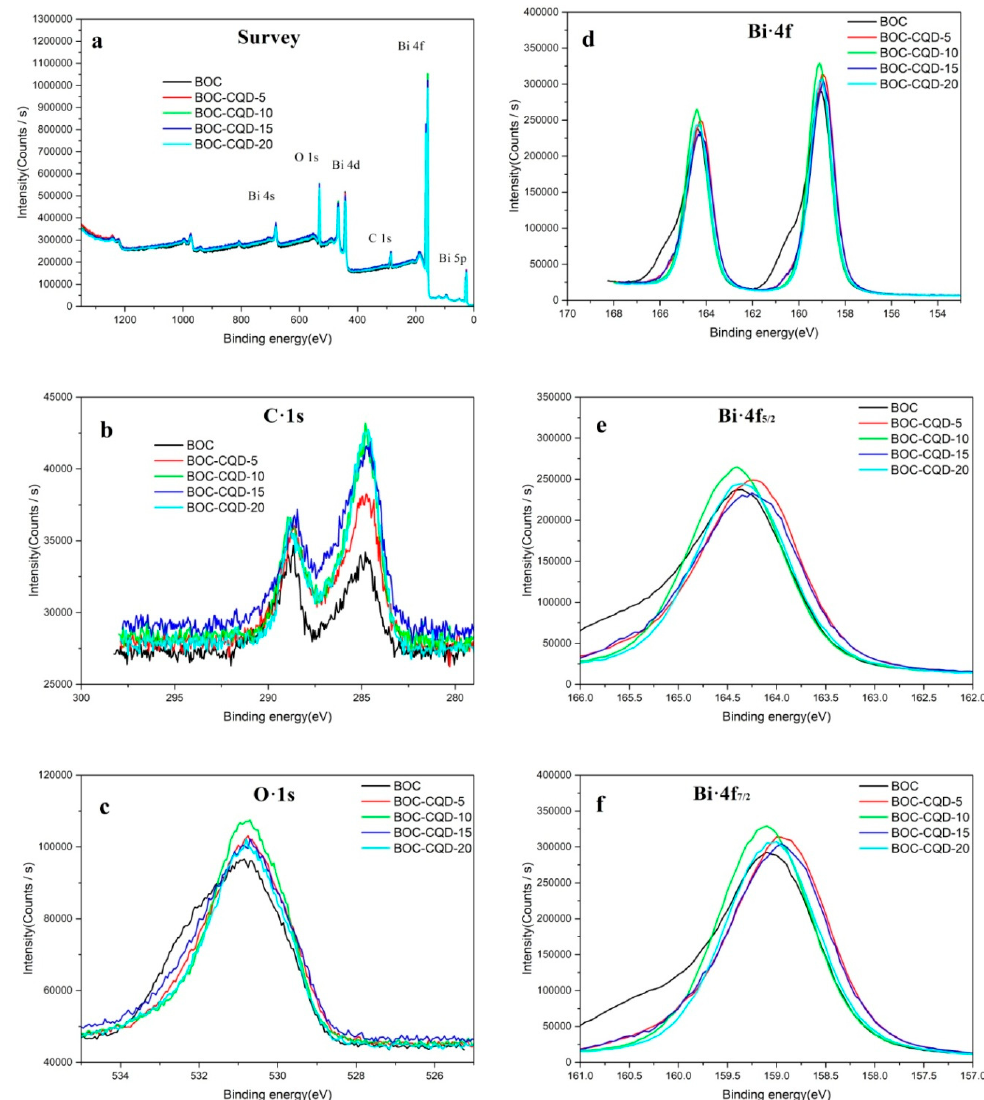
Figure 5. X-ray photoelectron spectroscopy (XPS) spectra of BOC samples: survey scan ( a ), C1s ( b ), O1s ( c ), and Bi-4f ( d – f ).